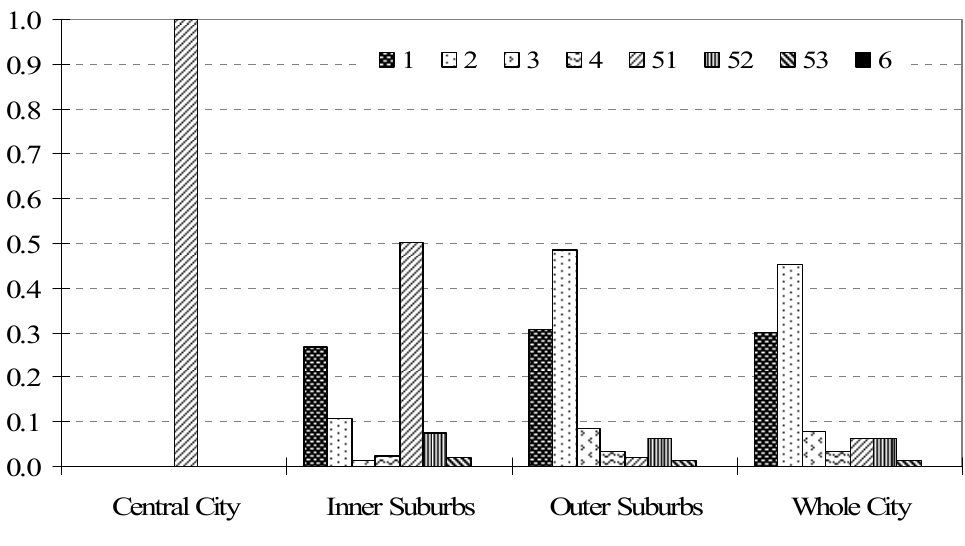
Figure 5. Beijing Land Use Structures by Suburbs in